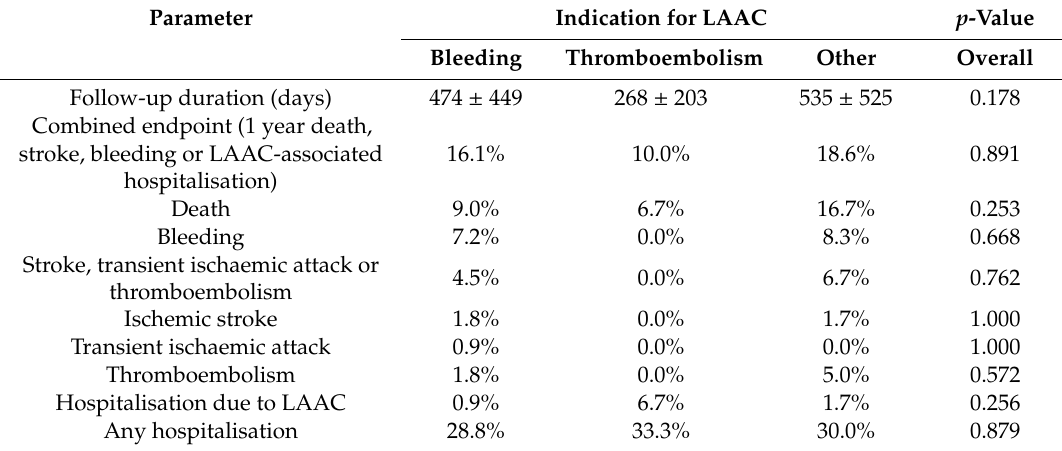
Table 2. Follow up after LAAC.